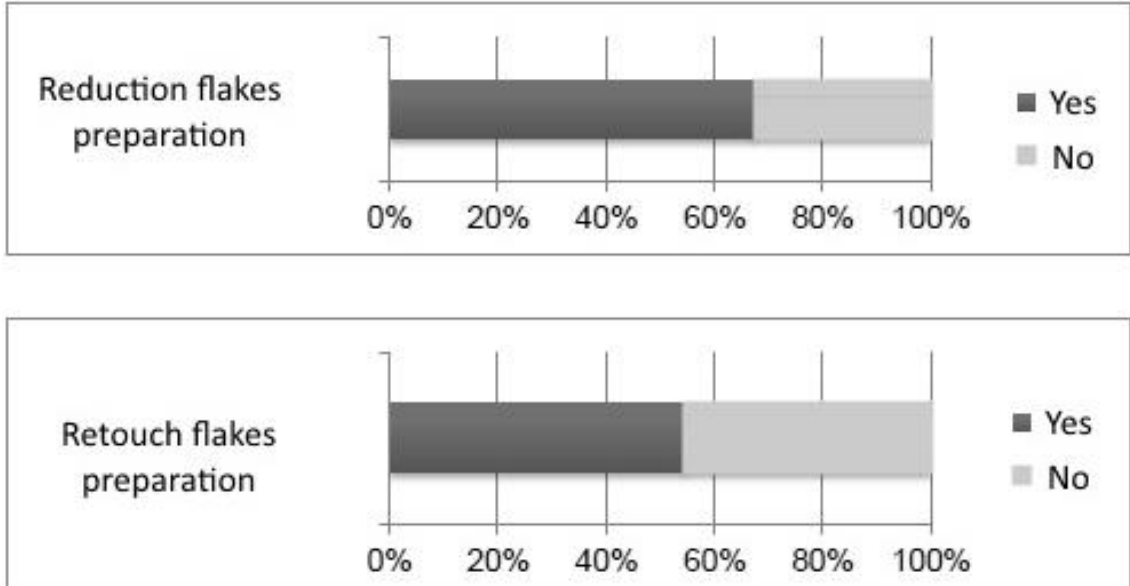
Figure 12. Reduction and retouch flakes platform preparation.